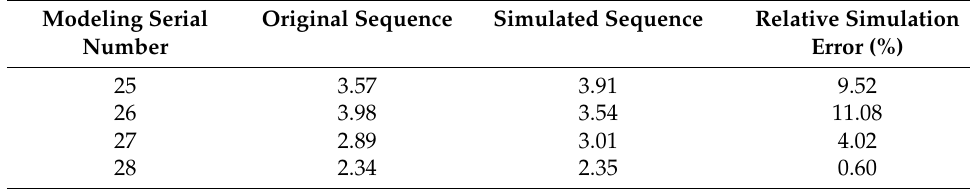
Table 6. The prediction results of absolute dry flexural